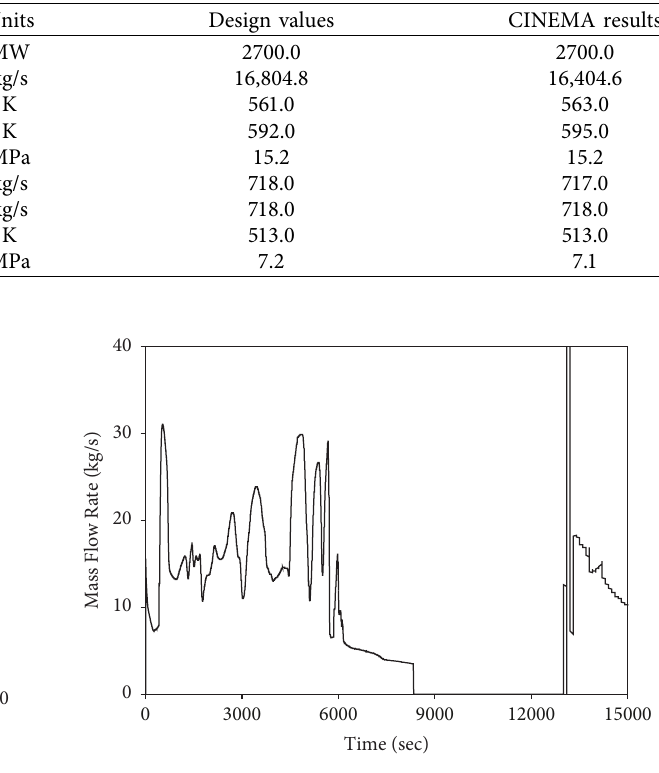
Figure 5: CINEMA results on mass fow rate through pressurizer PORV of the TMI-2 severe accident.